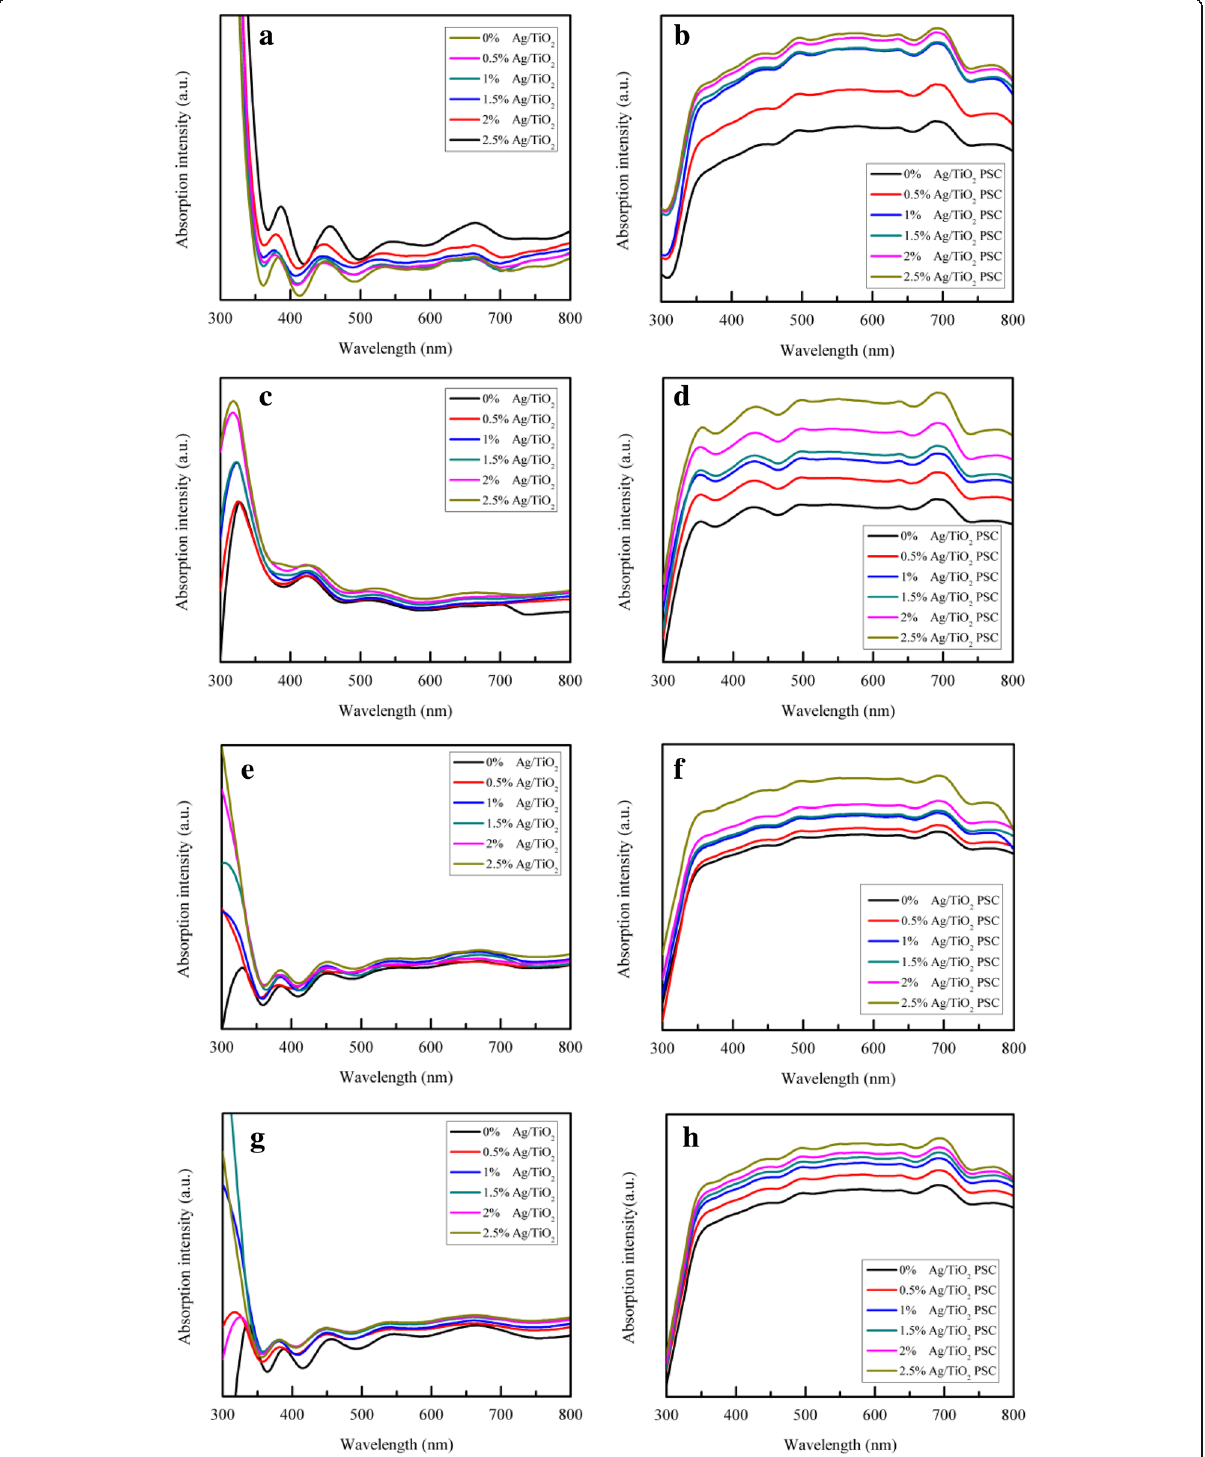
Fig. 5 UV-vis absorption spectra of the compact films and the whole PSC devices with a , b 10-nm Ag NPs; c , d 30-nm Ag NPs; e , f 40-nm Ag NPs; and g , h 55-nm Ag